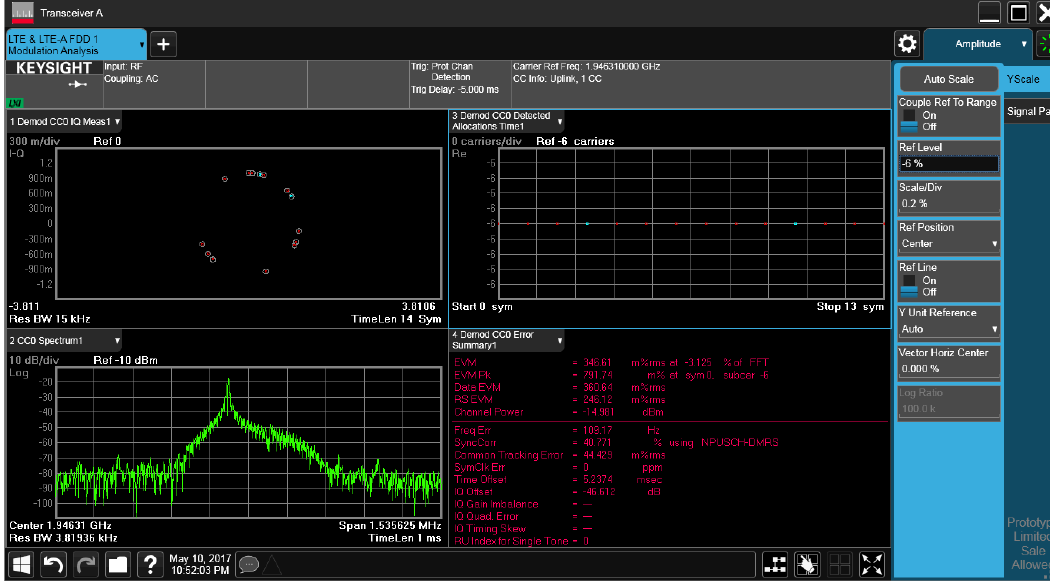
Figure 9. Spectrum, signal strength, and quality